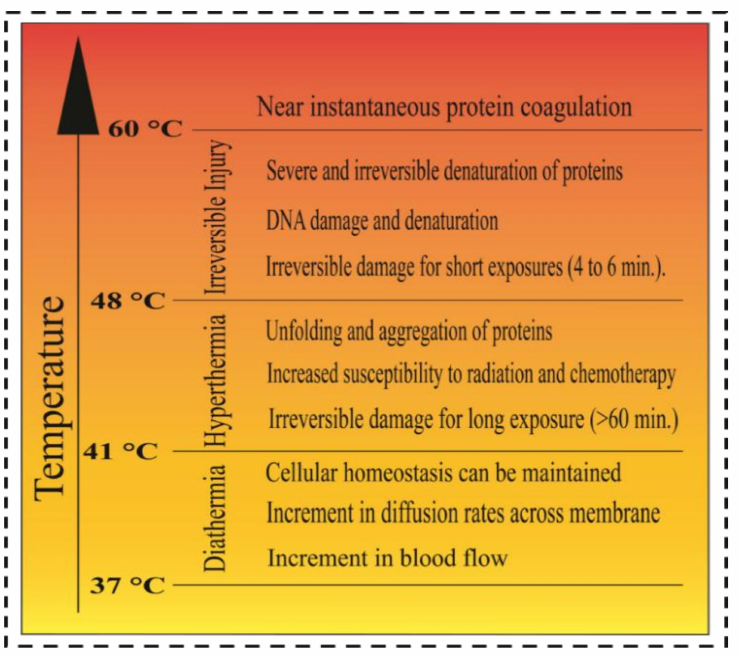
Figure 7. Different temperature states where the cells react differently leading to denaturation of the protein. Adapted with permission from Ref. [113] (Redrawn). 2014, Royal Society of